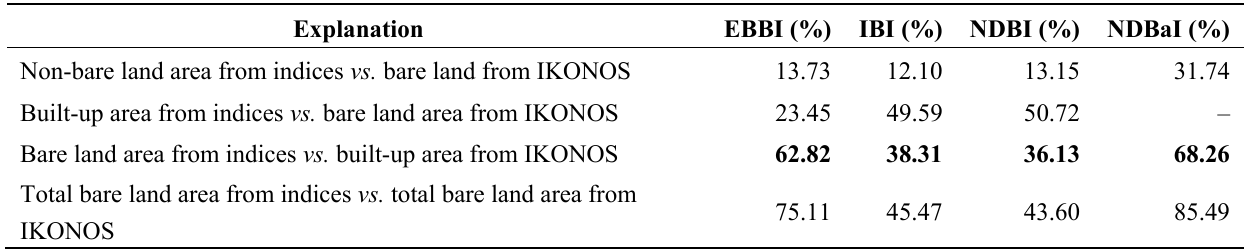
Table 6. The percent accuracies of the bare land area obtained from each type of index transformation. Explanation EBBI (%) IBI (%) NDBI (%) NDBaI (%) Non-bare land area from indices vs. bare land from IKONOS Built-up area from indices vs. bare land area from IKONOS 23.45 – Bare land area from indices vs. built-up area from IKONOS Total bare land area from indices vs. total bare land area from